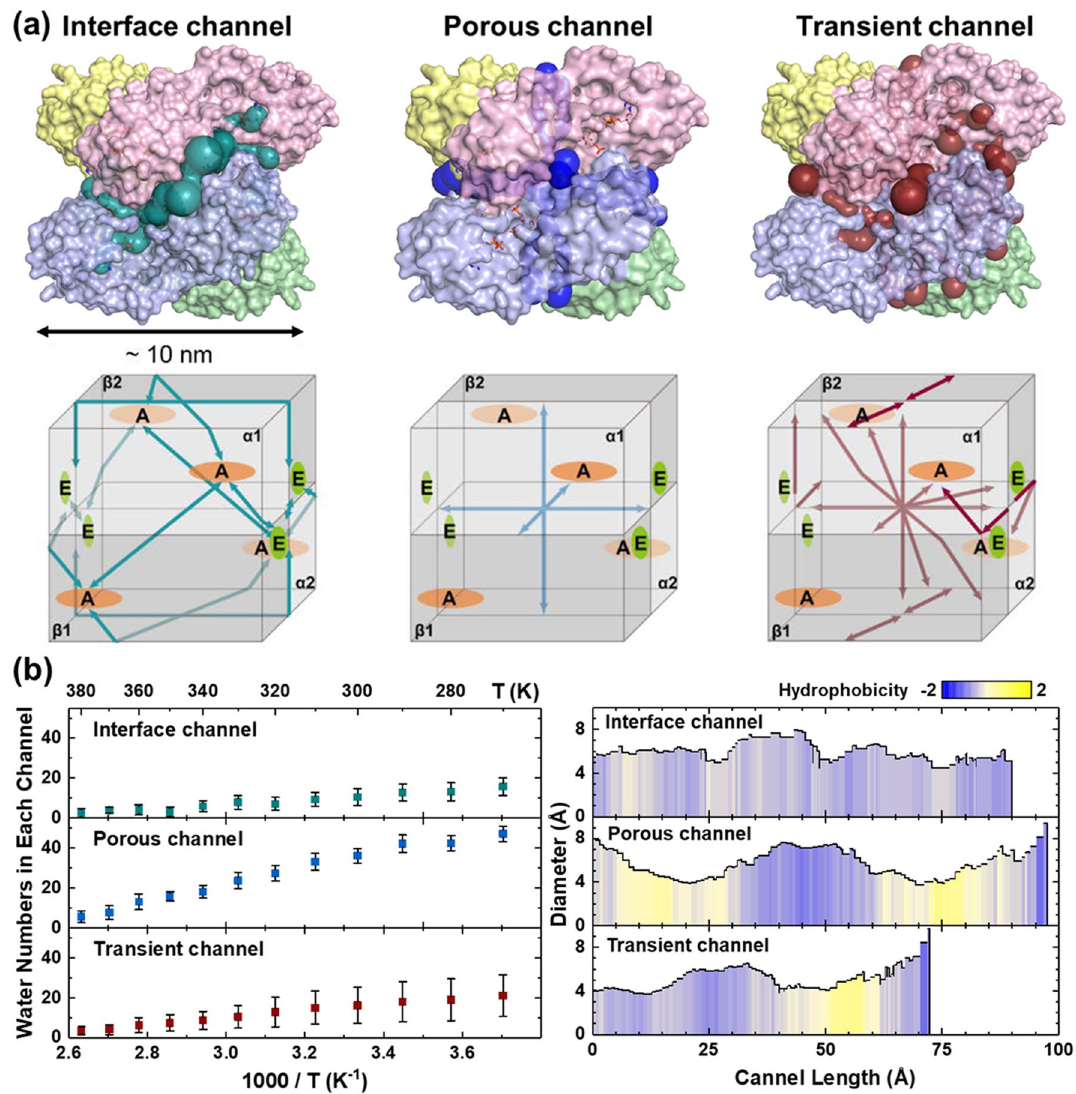
Figure 4. Identification of the site connection channels for the PFK-1 (PDB entry 1PFK) 45 tetramer matrix 45 , with three categories of ( a ) the interface, the porous channel, and the transient channel. The layout of these channels is mapped in connection with each effector and active site for the tetramer structure by Alphabetic Greek symbols, α 1 , α 2 , β 1 , and β 2 , indicating four PFK-1 monomers. The drawing may not be precise in scale, but it presents the symmetry in the tetramer structure. ( b ) On the left side, numbers of water molecules per channel, with standard deviation within 3 Å of the three different PFK-1 channel centers along the MD structure of 10 frames with a time interval of 100 ps at different temperatures. On the right side, comparison of the channel property with the hydrophobicity of channel residues. The interface channel is evenly distributed, and the porous and transient channels have more hydrophilic residues at the middle and entrance, two channels. However, we can identify the transient channel as the rest of the water channels of the enzyme, which are clearly different from either the interface channel or the porous channel. Each PFK-1 monomer has an active site and an effector site, and these sites are connected by channels in the tetramer complex. In the right side of Fig. 4b, we use MOLE online 46 to calculate and analyze the channels for the crystal structure (PDB entry 1PFK). The interface, porous and transient channel are about 90, 98 and 72 Å long and have bottlenecks of about 4.5, 3.7 and 3.7 Å wide, respectively. The interface channel is rather hydrophilic, for its hydrophobicity is − 0.79 to − 0.08. By comparison, the hydropathy values of the porous and transient channels range from − 1.07 to 0.80 and from − 1.07 to 0.63, respectively, suggesting that these channels are more variable than the interface channel. In terms of time, the transient channel changes more significantly than does the porous channel. In addition, these channels have different abilities to restrict water. The interface channel traps water with hydrophilic amino acids, whereas the porous channel space uses candy-shaped spaces to restrict water movement. Compared with the previous two, the transient channel has a very unstable water volume (note the larger error bar on the left side of Fig. 4b). These reasons make the function of the transient channel in regulating water diffusion very different from those of the other two.